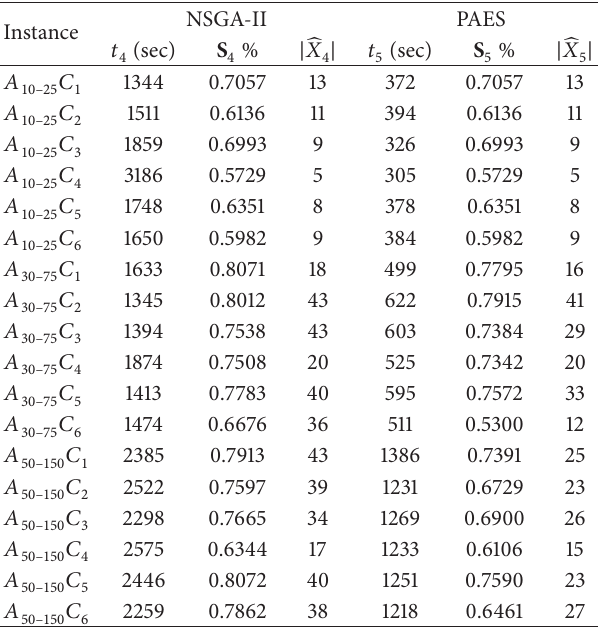
Table 5: Comparison among our BOCA implementations ( 𝐴 instances).